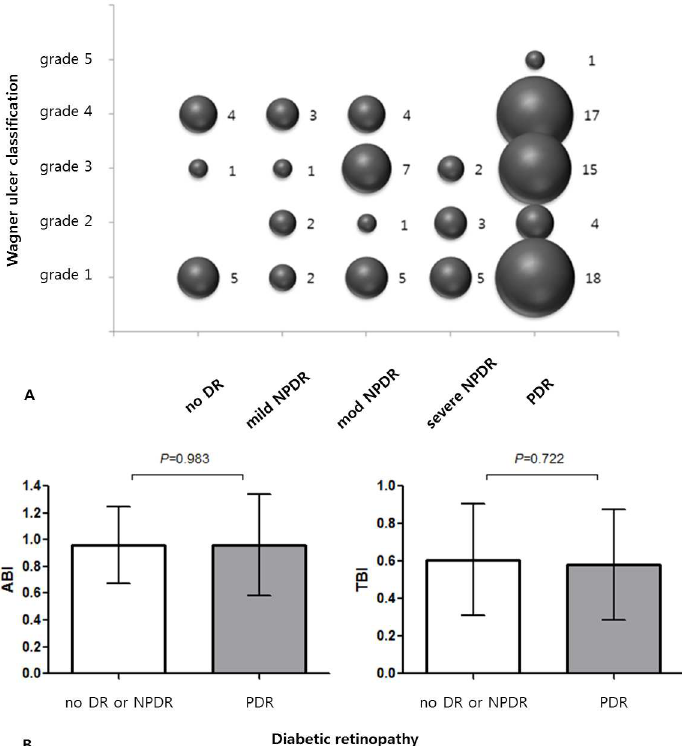
Fig 3. Correlations between the severitiesof diabetic retinopathy (DR) and diabetic foot ulcer (DFU) or other vascularindex. (A) No correlationwas shown betweenthe severitiesof DR and DFU ( R = 0.034, p = 0.734, Pearson’s correlationanalysis).The numbers adjacent to the circles indicate sample size. (B) The severity of DR and ABI or TBI value also showedno significantassociation(p = 0.983 and 0.722, respectively, independent t test).